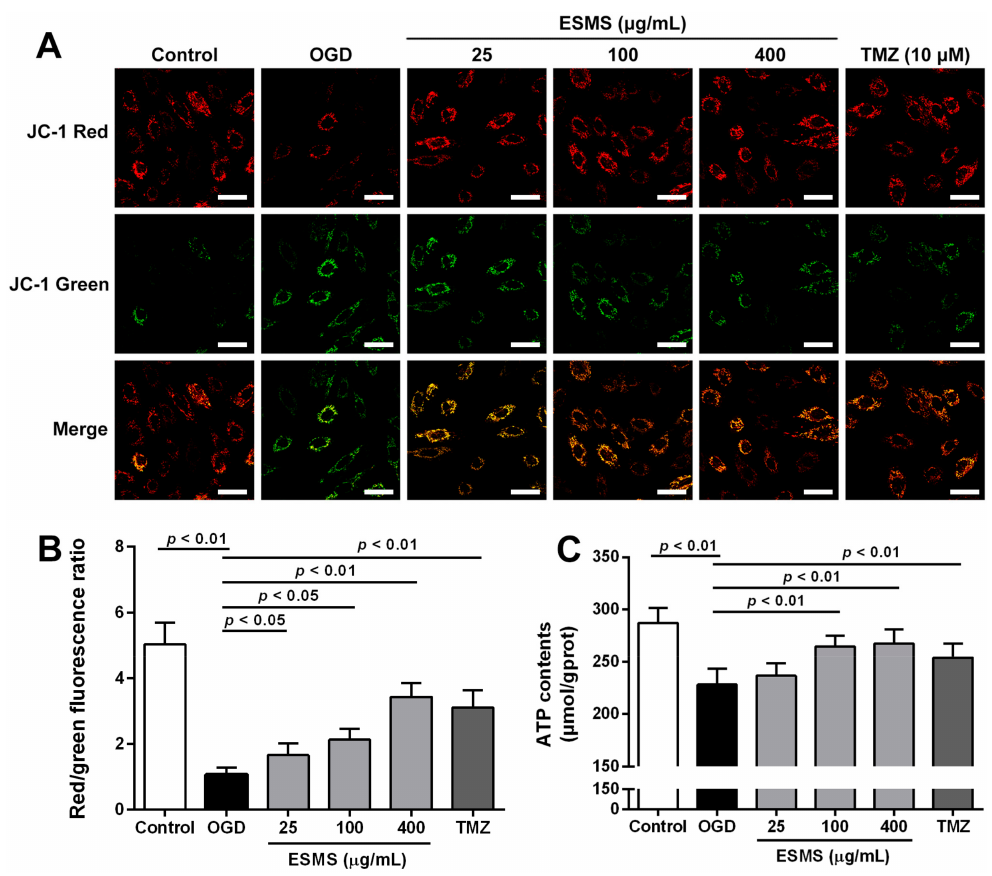
Figure 6. ESMS restored mitochondrial membrane potential and cellular ATP content in H9c2 cells subjected to OGD. ( A ) Mitochondrial membrane potential was evaluated by the probe JC-1. Green fluorescence shows JC-1 monomer, which enters in the cytosol following mitochondrial membrane depolarization. Red fluorescence indicates the JC-1 aggregation, which is accumulated in the inner membrane of mitochondria. Bar is 40 µ m ( n = 3); ( B ) Quantitative analysis of mitochondrial membrane potential ( n = 3); ( C ) Cellular ATP content was evaluated ( n = 6). Results were presented as mean ± SD. TMZ = Trimetazidine dihydrochloride (positive